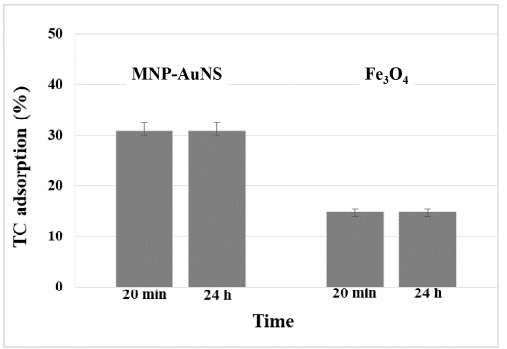
Figure 5. Amount of TC adsorbed on Fe 3 O 4 NPs and MNP-AuNS, for an initial concentration of 10 µ M in the antibiotic.